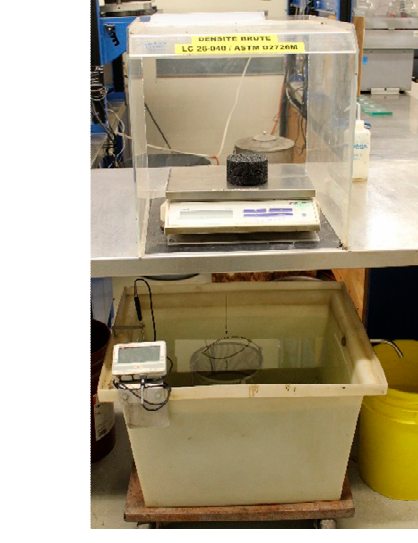
Figure 5. Marshall method: ( a ) compaction of the specimens; ( b ) hydrostatic weighing.